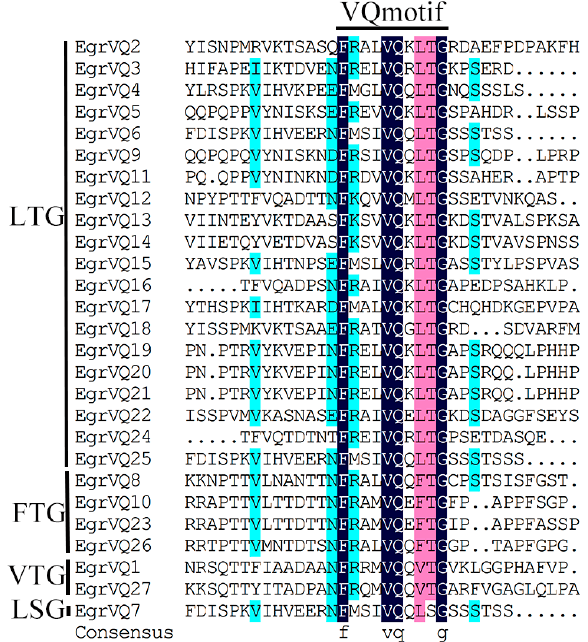
Figure 3. Multiple sequence alignment of VQ proteins in E. grandis . Sequences were aligned using DNAMAN software. The FxxxVQxxxG motif was highly conserved. The dark blue indicated the conserved section of EgrVQs protein family. The pink indicated the four conserved motif variations of LGT, FTG, VTG, and LSG.